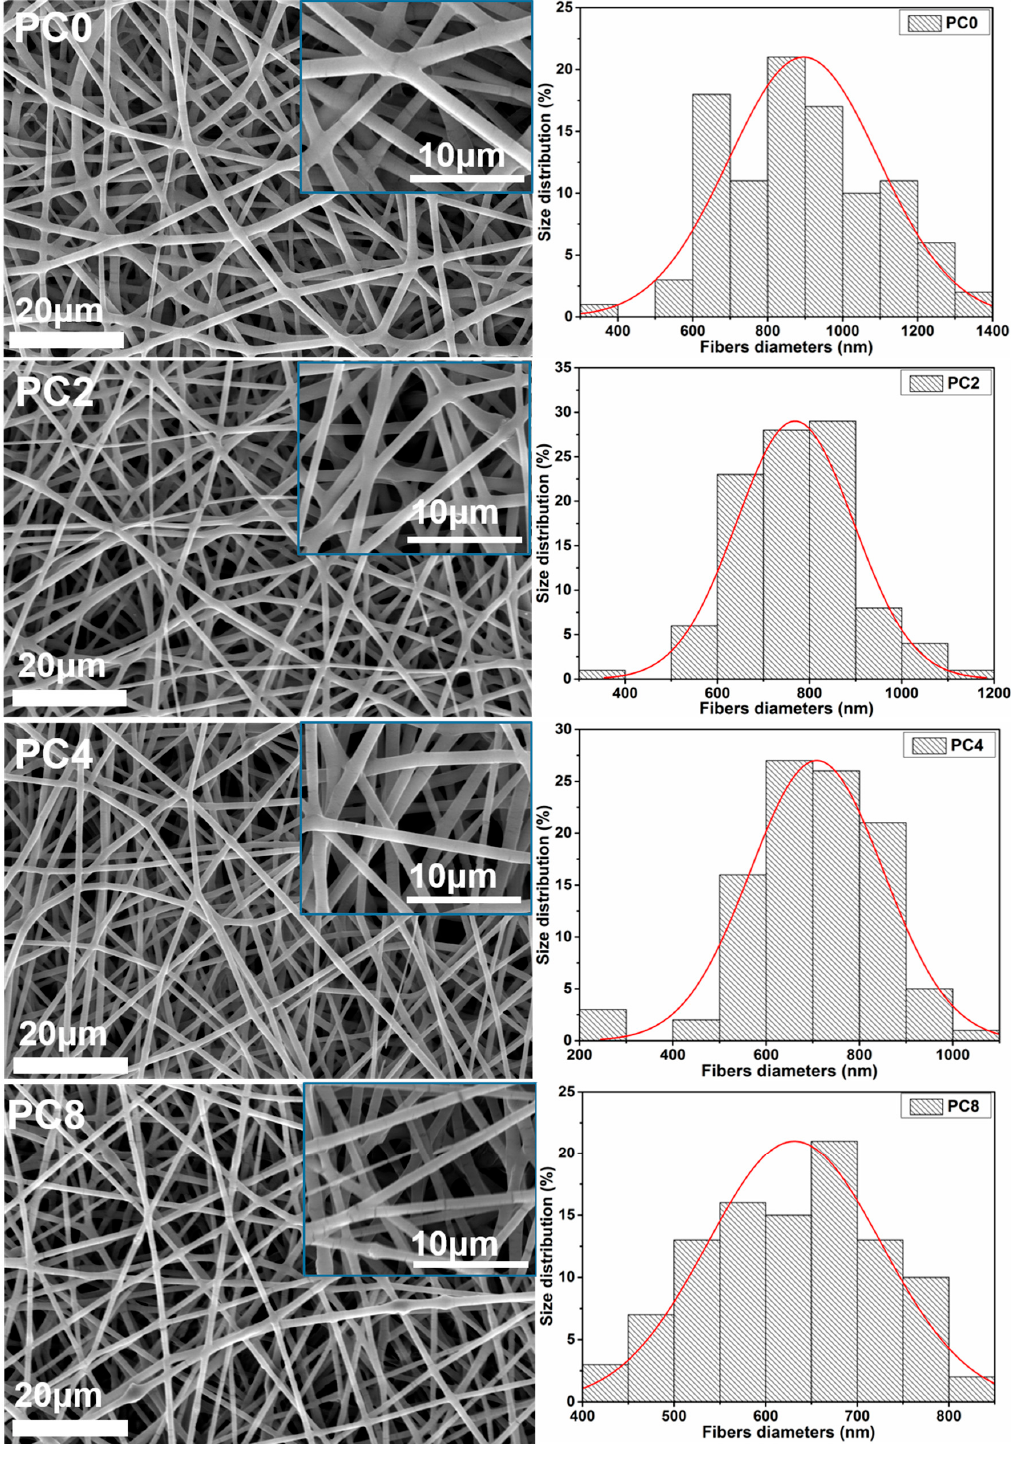
Figure 2. SEM images of electrospun nanofibers as well as the distribution of their diameters.